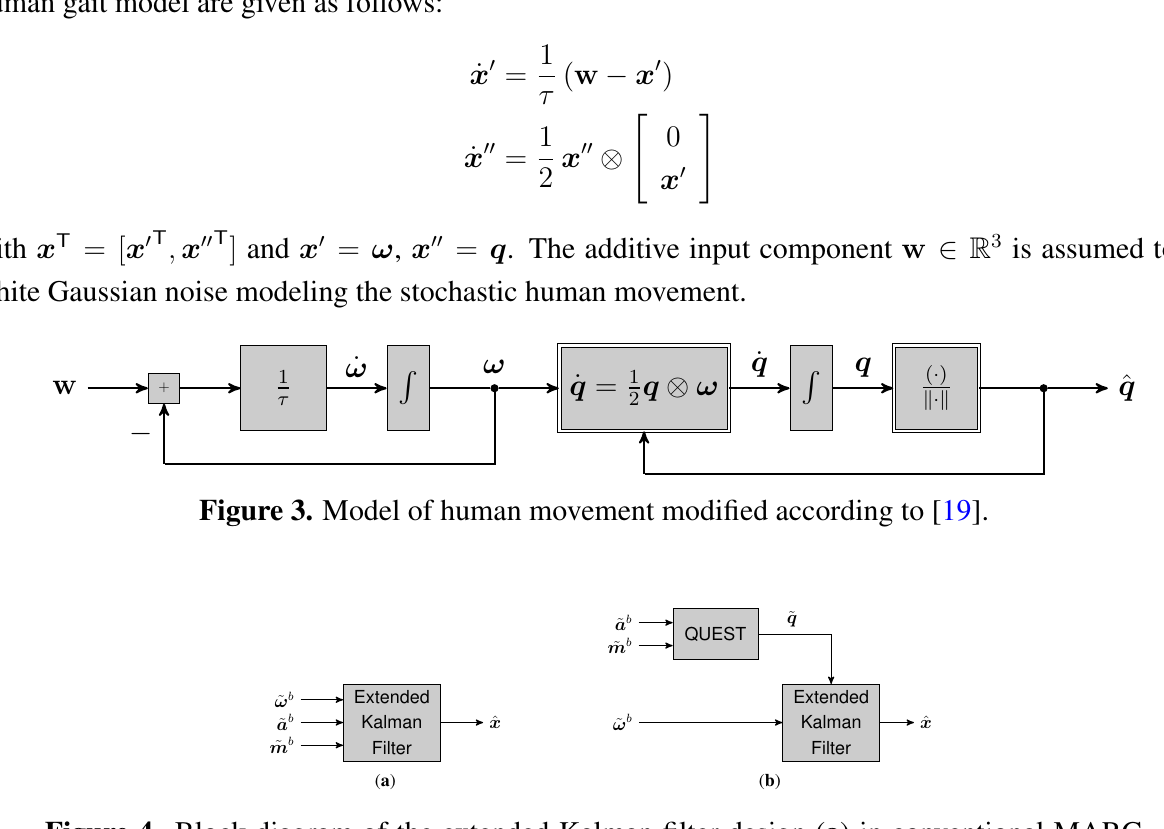
Figure 4. Block diagram of the extended Kalman filter design ( a ) in conventional MARG orientation estimation and ( b ) with quaternion estimator (QUEST)